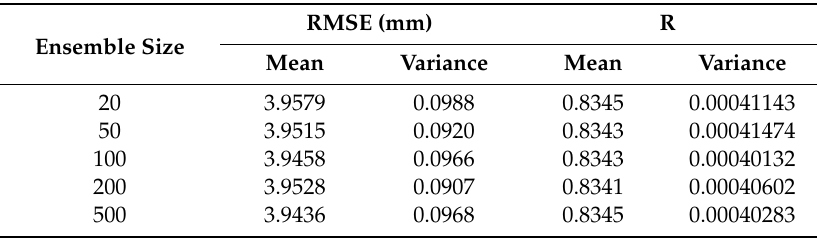
Table 4. The mean and variance of the RMSE and R between the CCI data and the data assimilation experiments with di ff erent ensemble sizes.